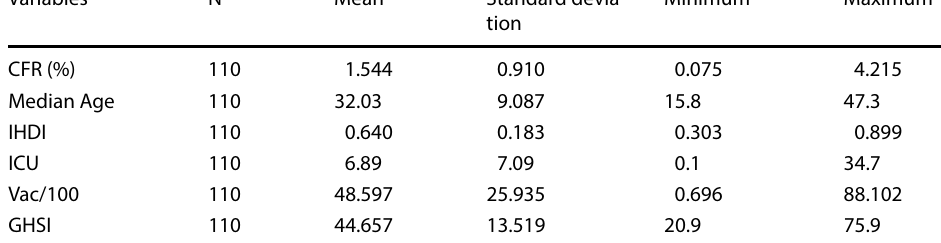
Table 1 Descriptive statistics for COVID-19 CFR and selected Socioeconomic Indicators